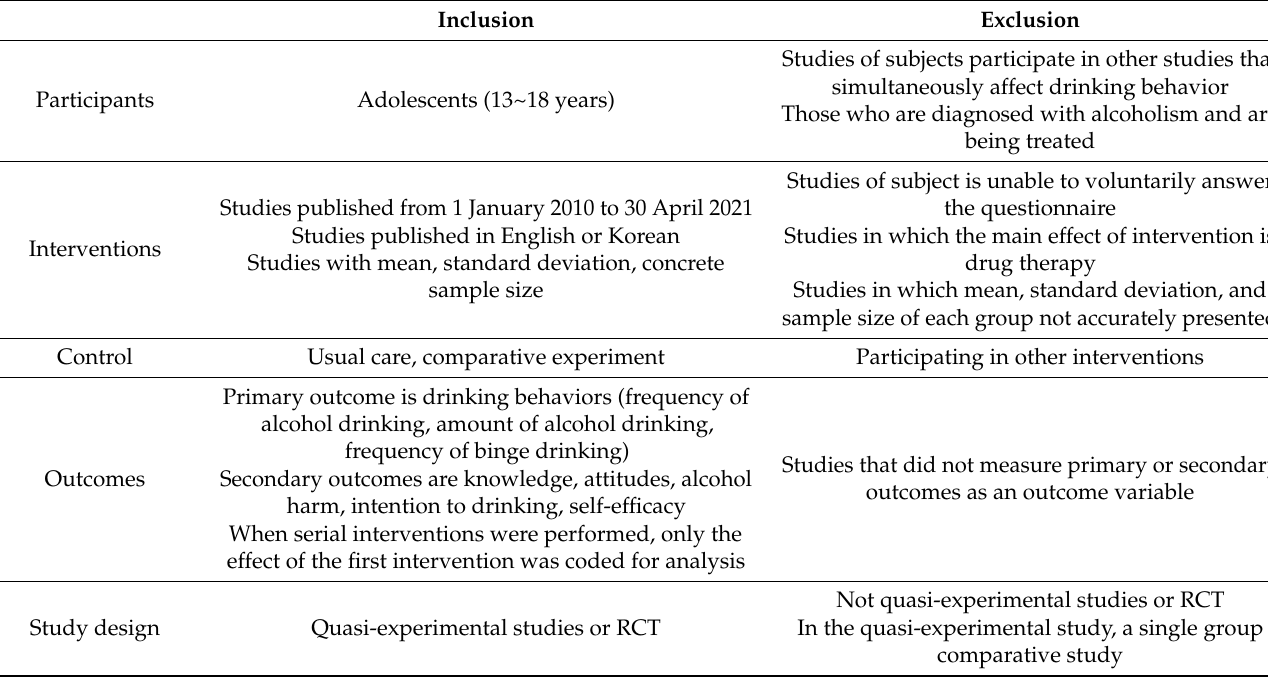
Table 1. Eligibility